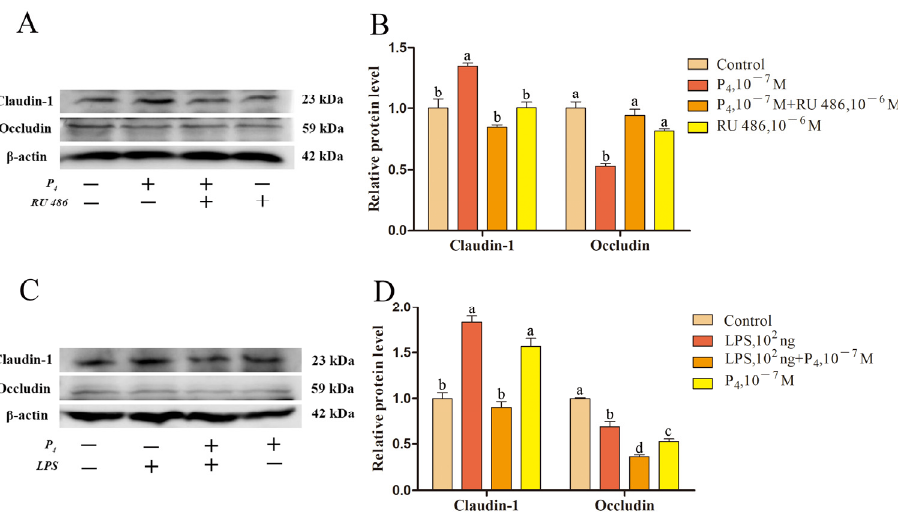
Figure 11. LPS affects claudin-1 and occludin protein expression in endometrial epithelial cells via P 4 receptors. ( A ) Western blotting of P 4 and RU 486-treated epithelial cells. ( B ) Relative expression level of epithelial cell proteins treated with P 4 and RU 486. ( C ) Western blotting of LPS and P 4 -treated epithelial cells. ( D ) Relative expression level of epithelial cell proteins treated with LPS and P 4 . Different lowercase letters indicate a significant difference at p < 0.05. RU 486, progesterone receptor inhibitor. Concentration is measured in